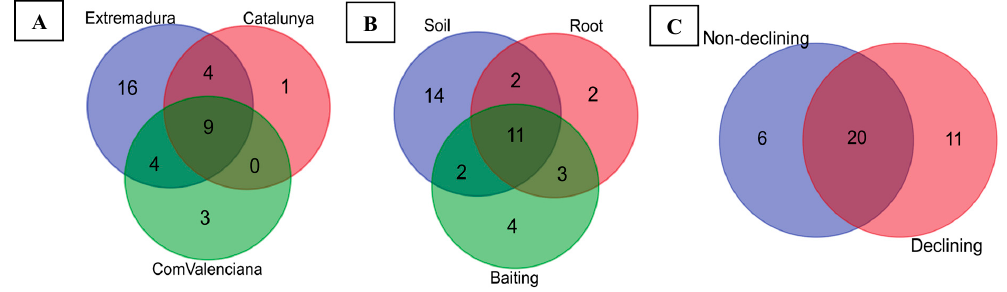
Figure 5. Venn diagram showing the overlap of operational taxonomic units (OTUs) identified in the Phytophthora population present in the holm oaks surveyed in the study according to the different factors studied. ( A) : Regions surveyed; Extremadura, Comunidad Valenciana (ComValenciana) and Cataluña (Catalunya), ( B) : Type of material used for the detection; roots, soils and baitings. ( C) : Symptomatology of the holm oaks sampled: declining and non-declining.